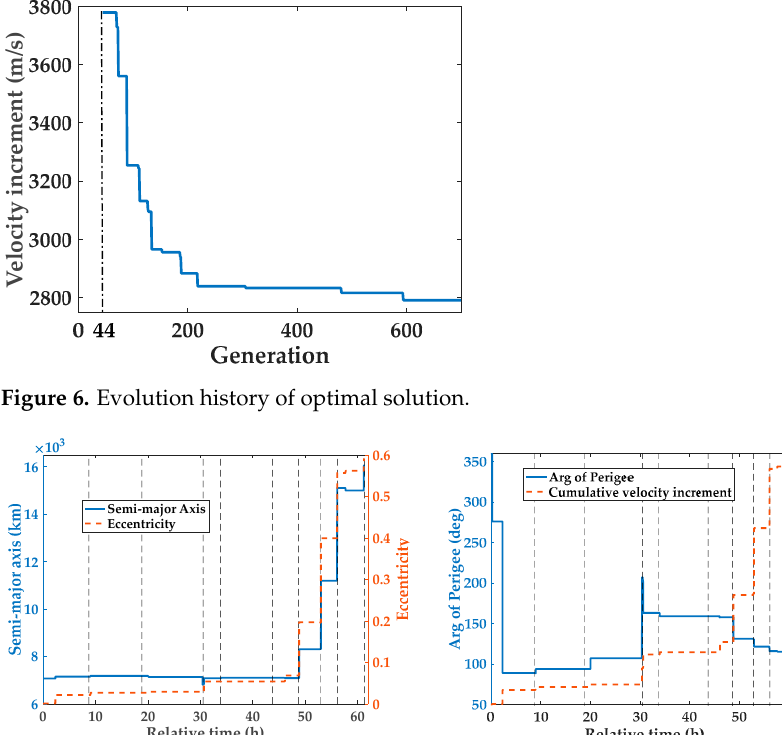
Table 6. Constraint values of each inspection task of example 2.